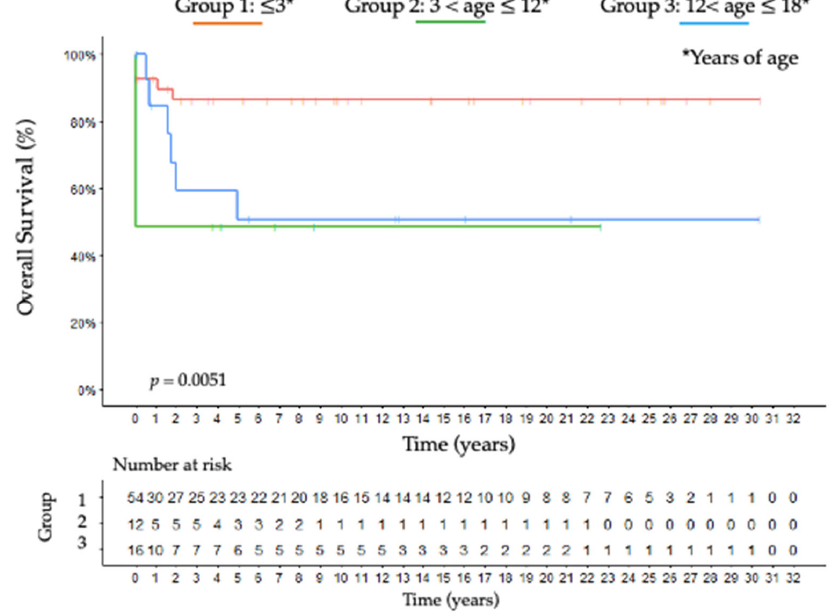
Figure 4. Kaplan ‐ Meier curve estimates for overall survival according to each age ‐ group; group 1: ≤ 3 years of age; group 2: 3 < age ≤ 12 years of age; group 3: 12 < age ≤ 18 years of